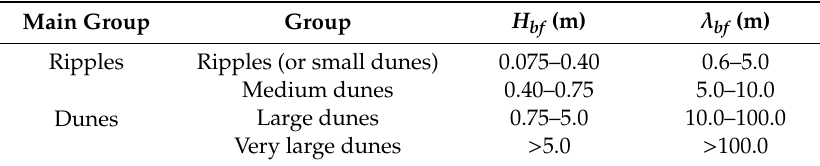
Table 1. Classification of bedforms according to Ashley et al.